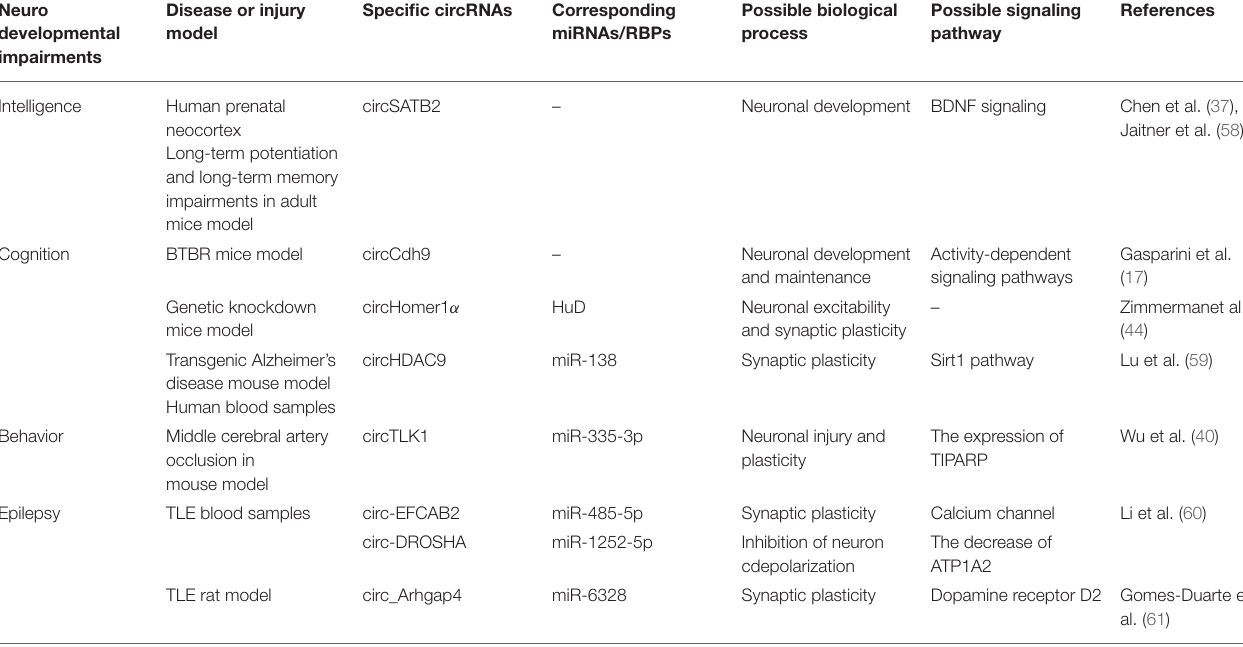
TABLE 1 | Overview of circRNAs in neurodevelopmental